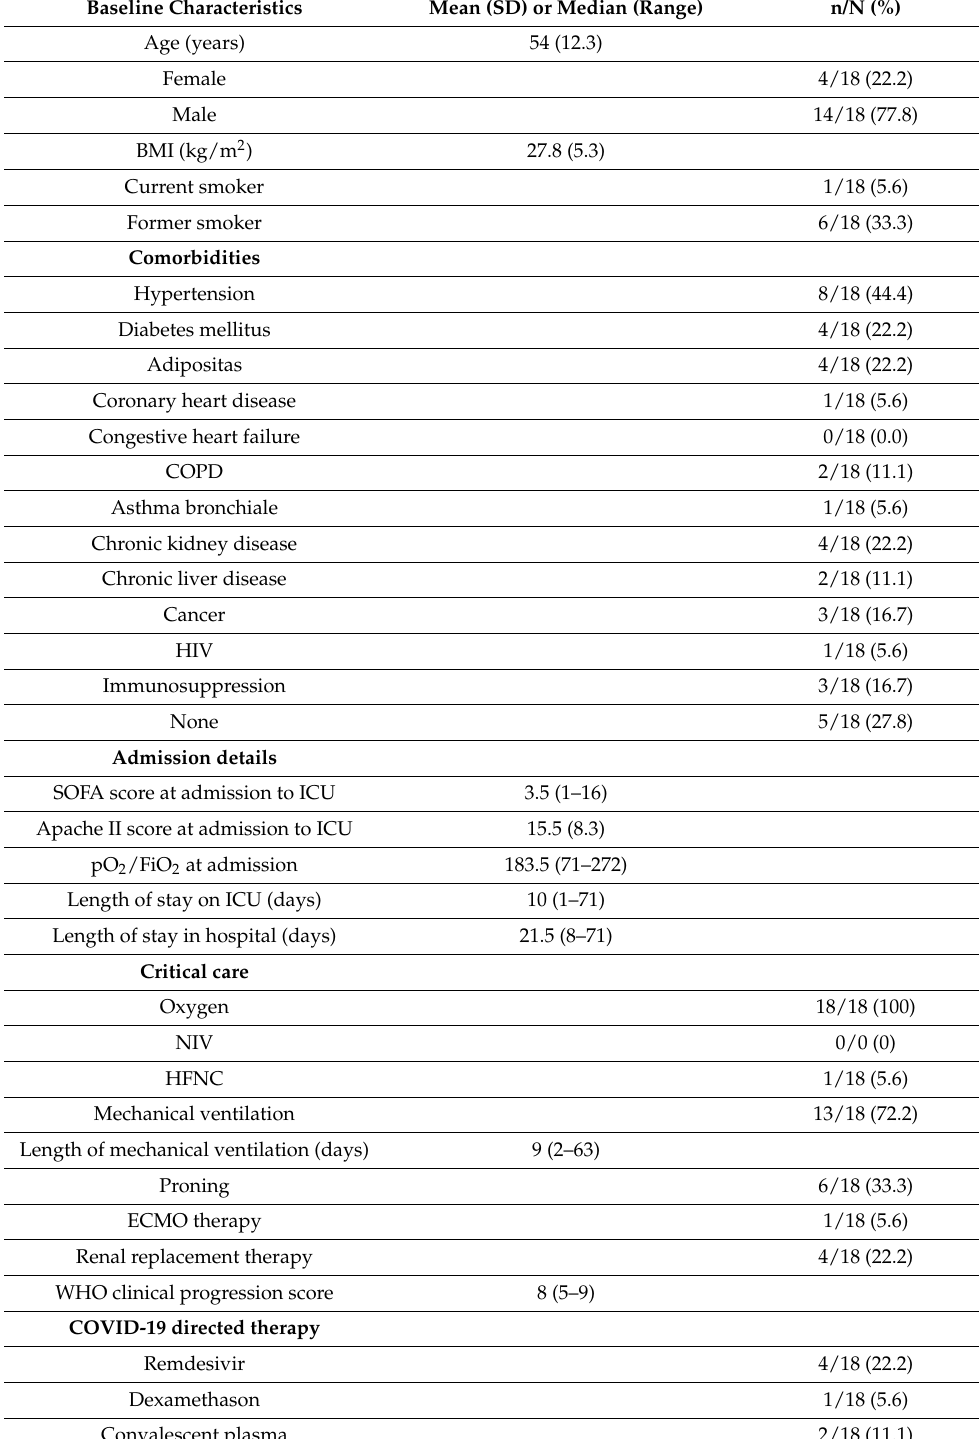
Table 1. Demographics, baseline characteristics and clinical